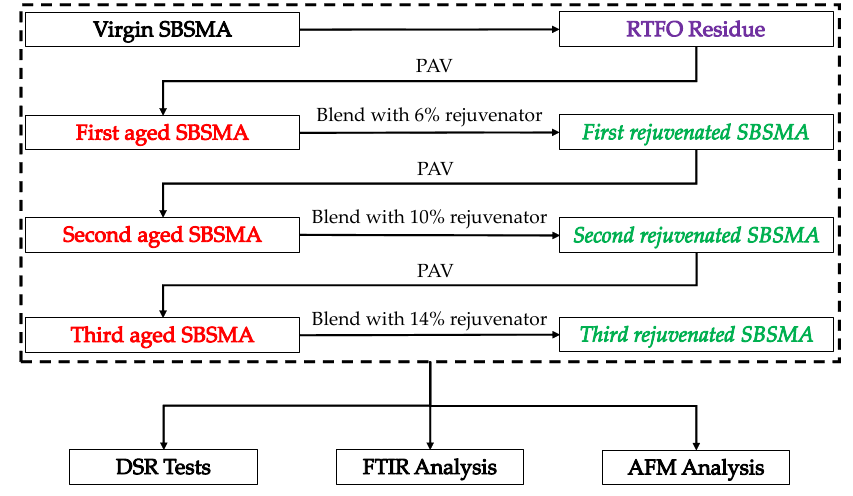
Figure 2. Experimental flow chart.